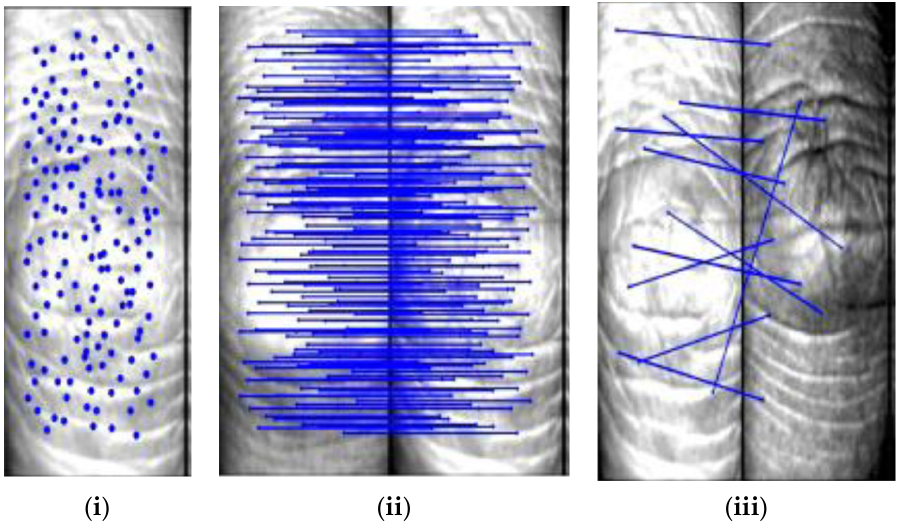
Figure 7. ( i ) SURF points ( ii ) Matched points ( iii ) Non-matched points.